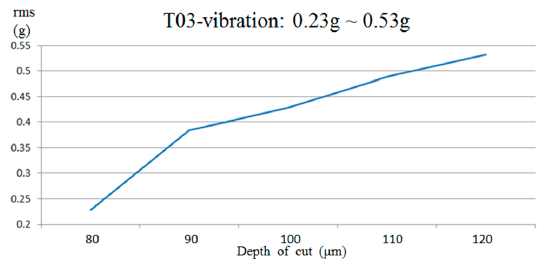
Figure 9. Cutting vibration vs. depth of cut for T03.